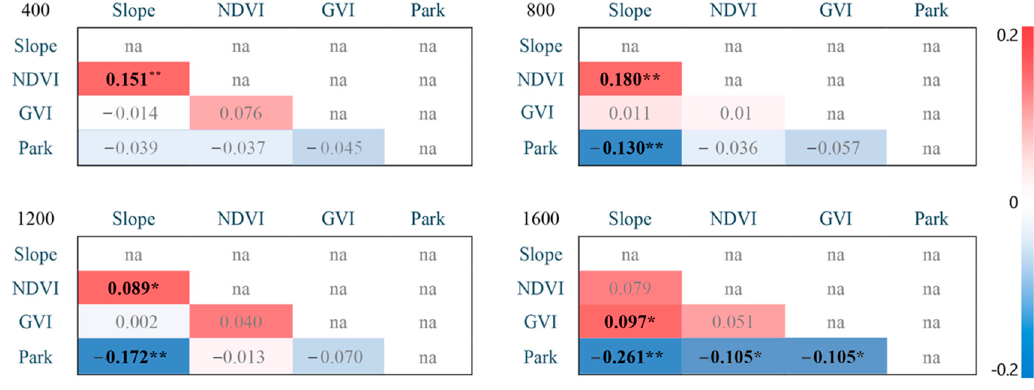
Figure 6. Correlations of multiple greenery indicators at different scales.